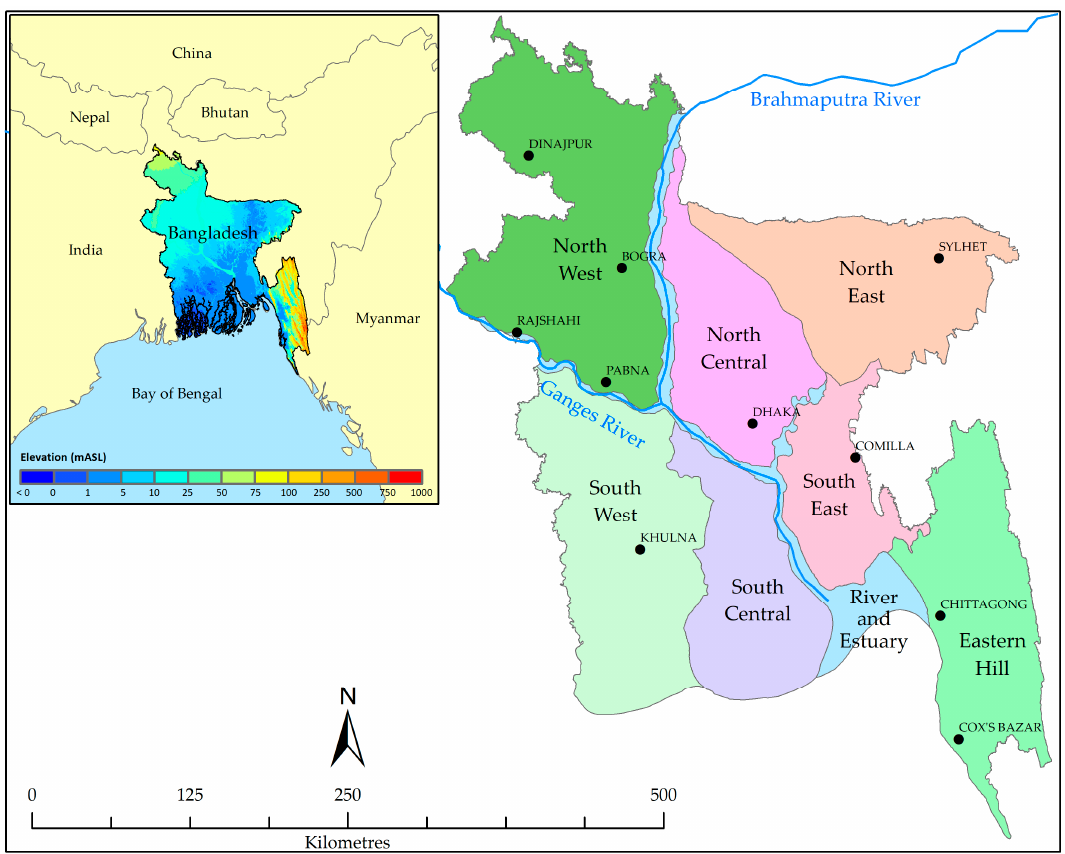
Figure 1. Hydrological regions of Bangladesh, with the major river network, cities, and elevation above mean sea level.